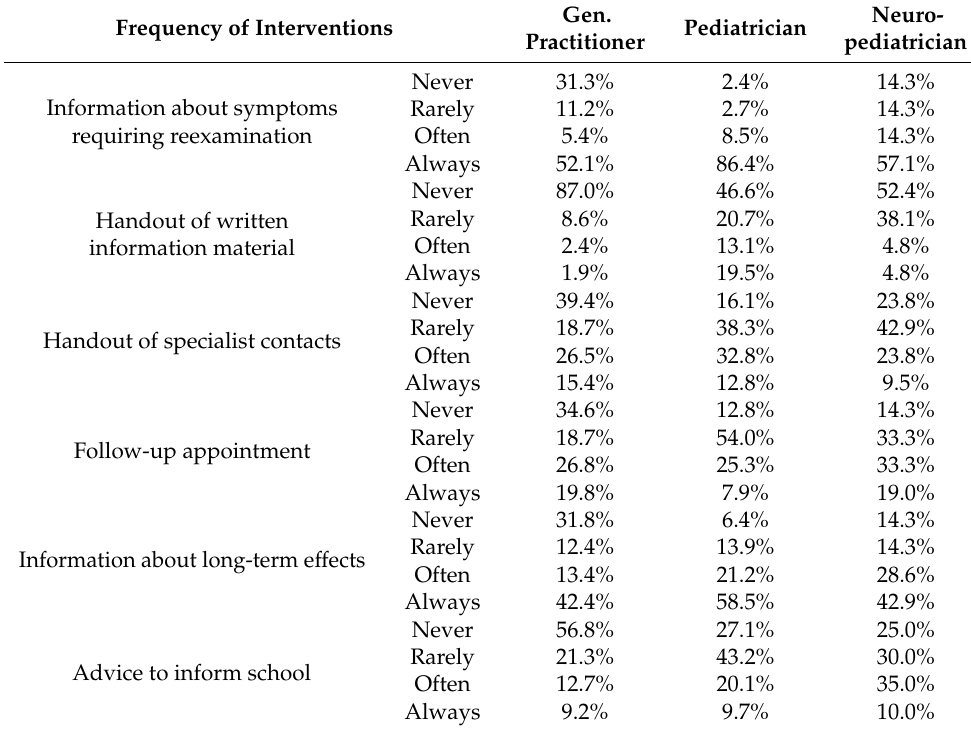
Table 4. Frequencies of interventions among the different